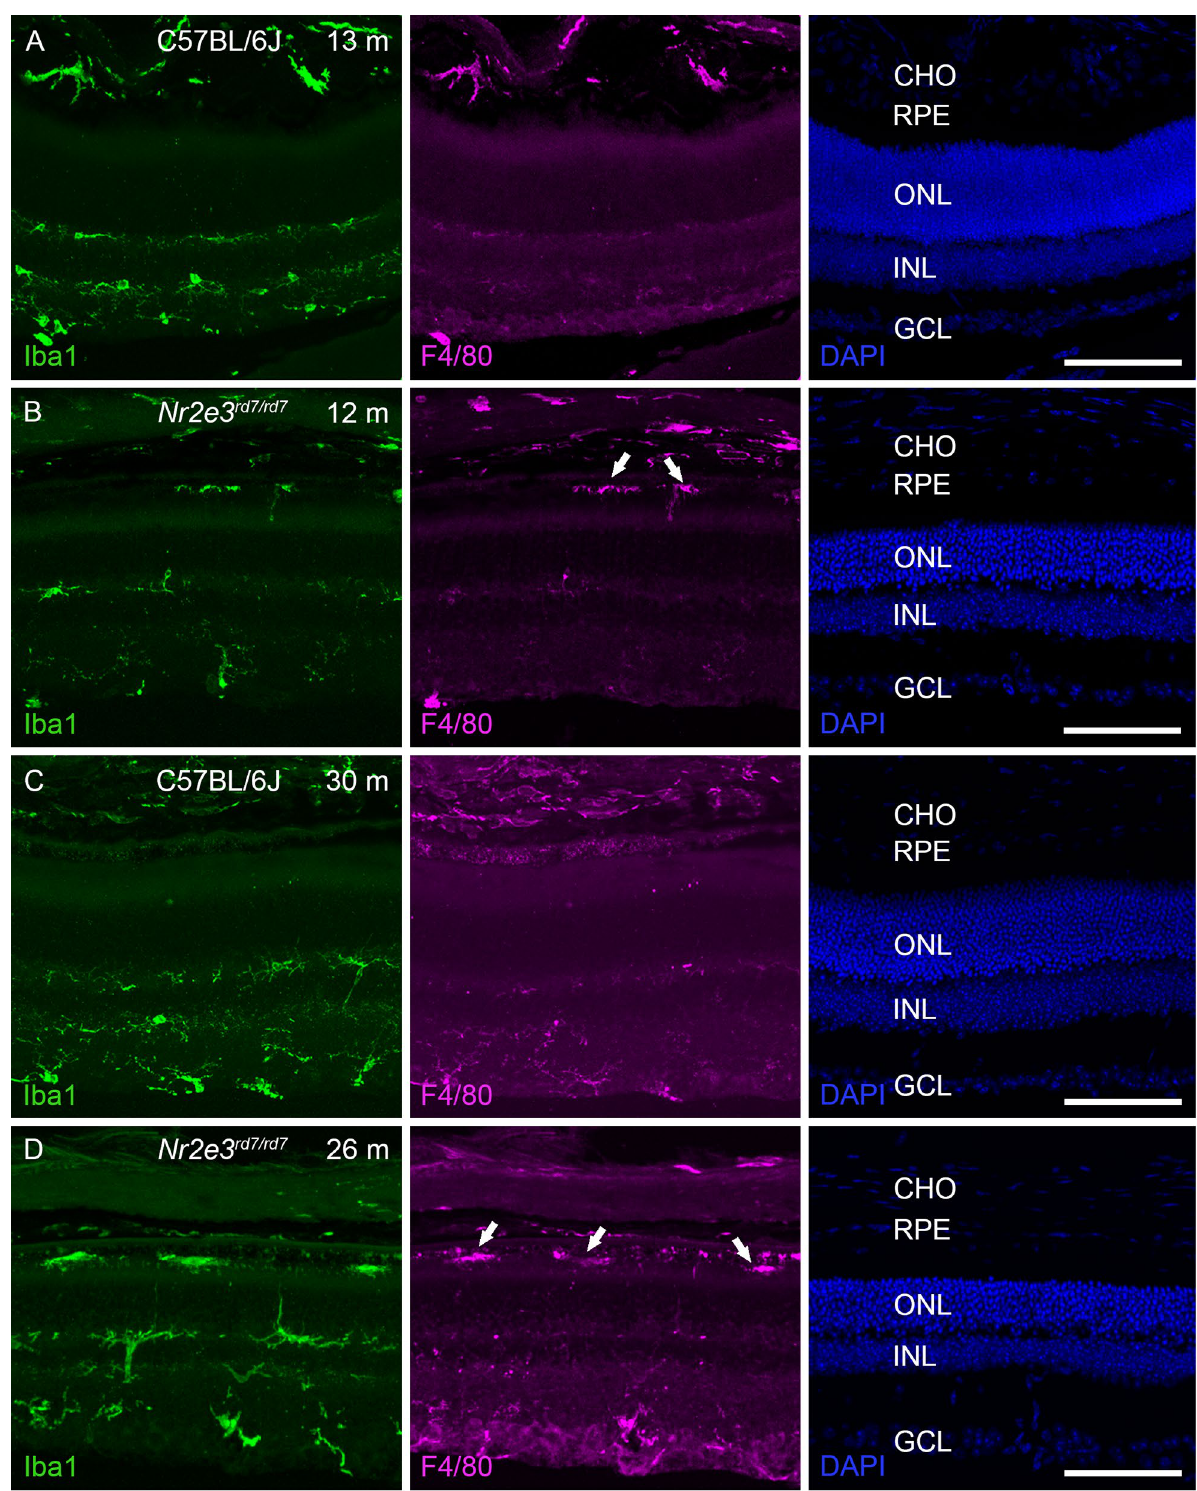
Figure 5. Inflammatory response in aged C57BL/6J Nr2e3 rd7/rd7 retinas. Iba1 (left column panels) and F4/80 (middle column panels) antigen staining on C57BL/6J retinas at 13 ( A ) and 30 months (m) ( C ), and on C57BL/6J Nr2e3 rd7/rd7 retinas at 12 ( B ) and 26 months ( D ). All sections were counterstained with DAPI to visualize cell nuclei (right column panels). Note decreased ONL thickness in C57BL/6J Nr2e3 rd7/rd7 retinas. Localization of Iba1 positive and F4/80 positive cells in the subretinal space is indicated by white arrows in ( B ) and ( D ). CHO: choroid; RPE: retinal pigment epithelium; ONL: outer nuclear layer; INL: inner nuclear layer; GCL: ganglion cell layer. Scale bars: 100